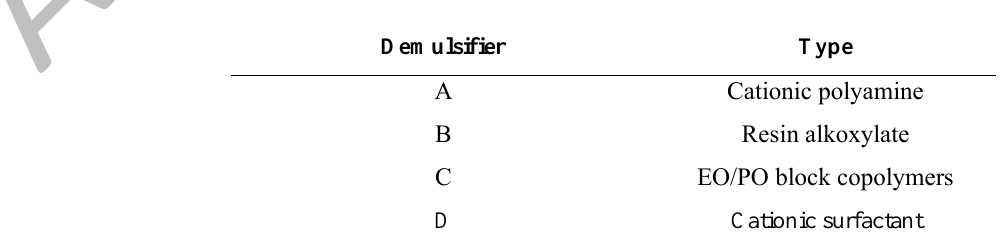
Table 1– Characteristics of the condensate